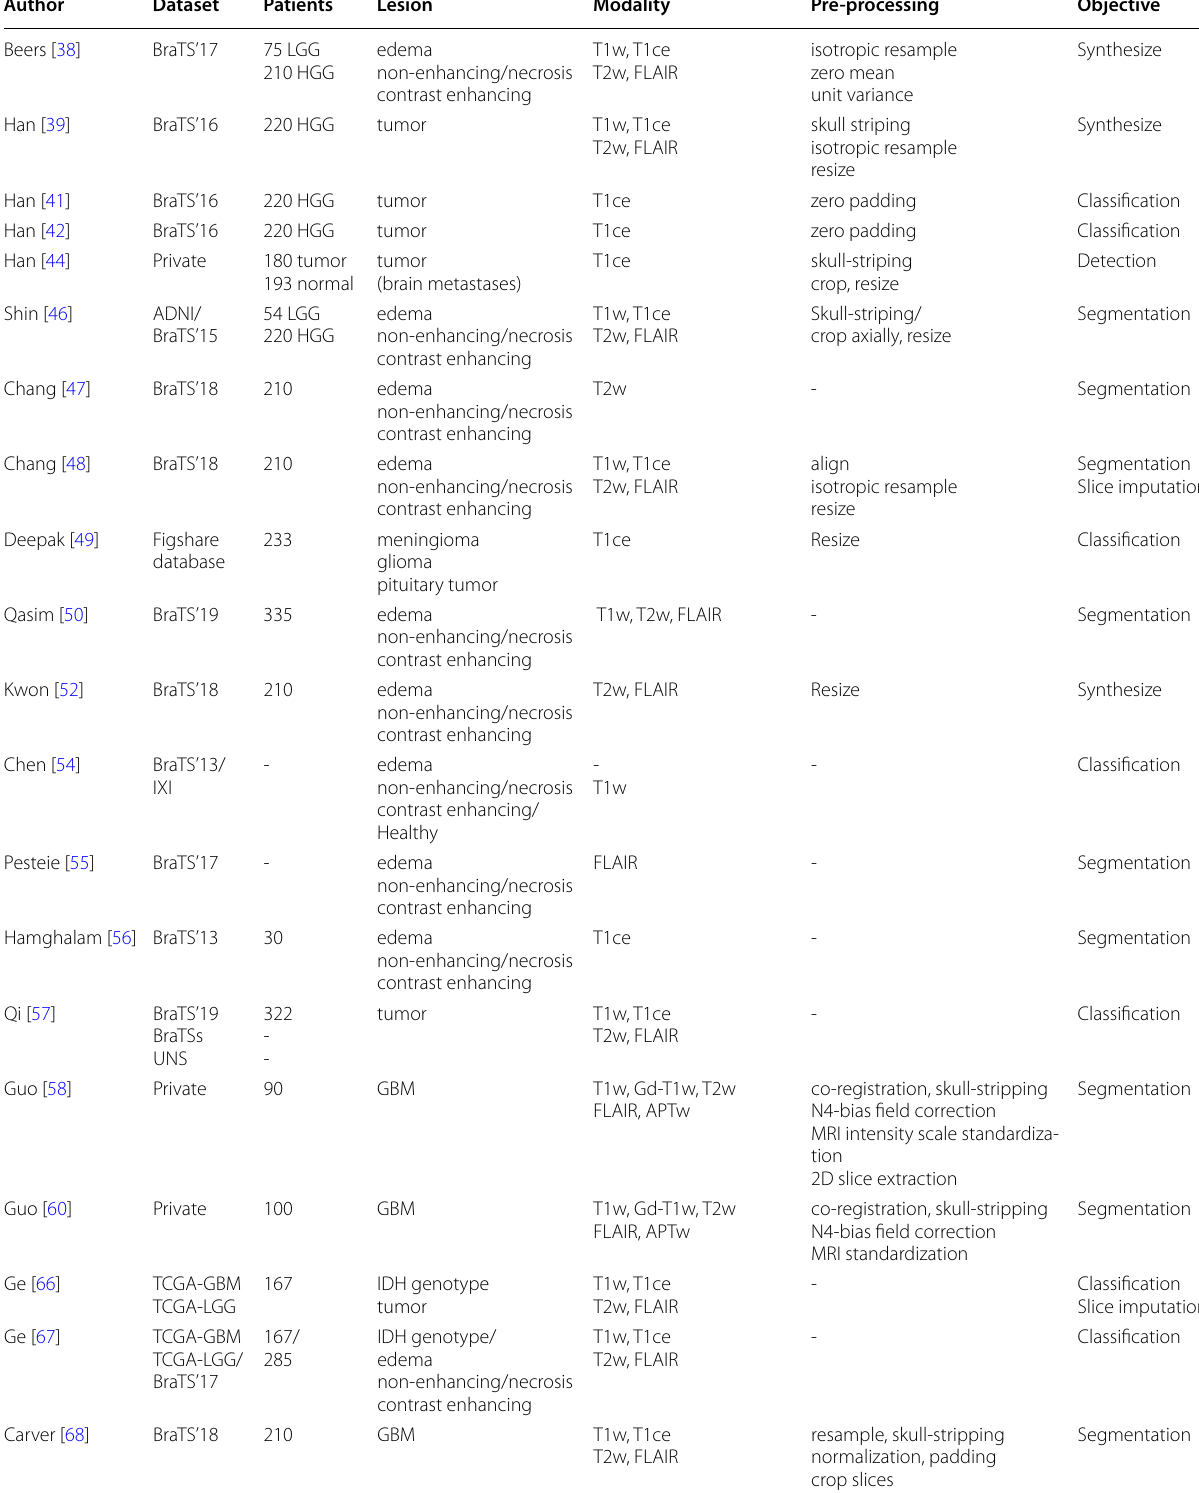
Table 1 Details of the datasets and data processing methods used in the examined